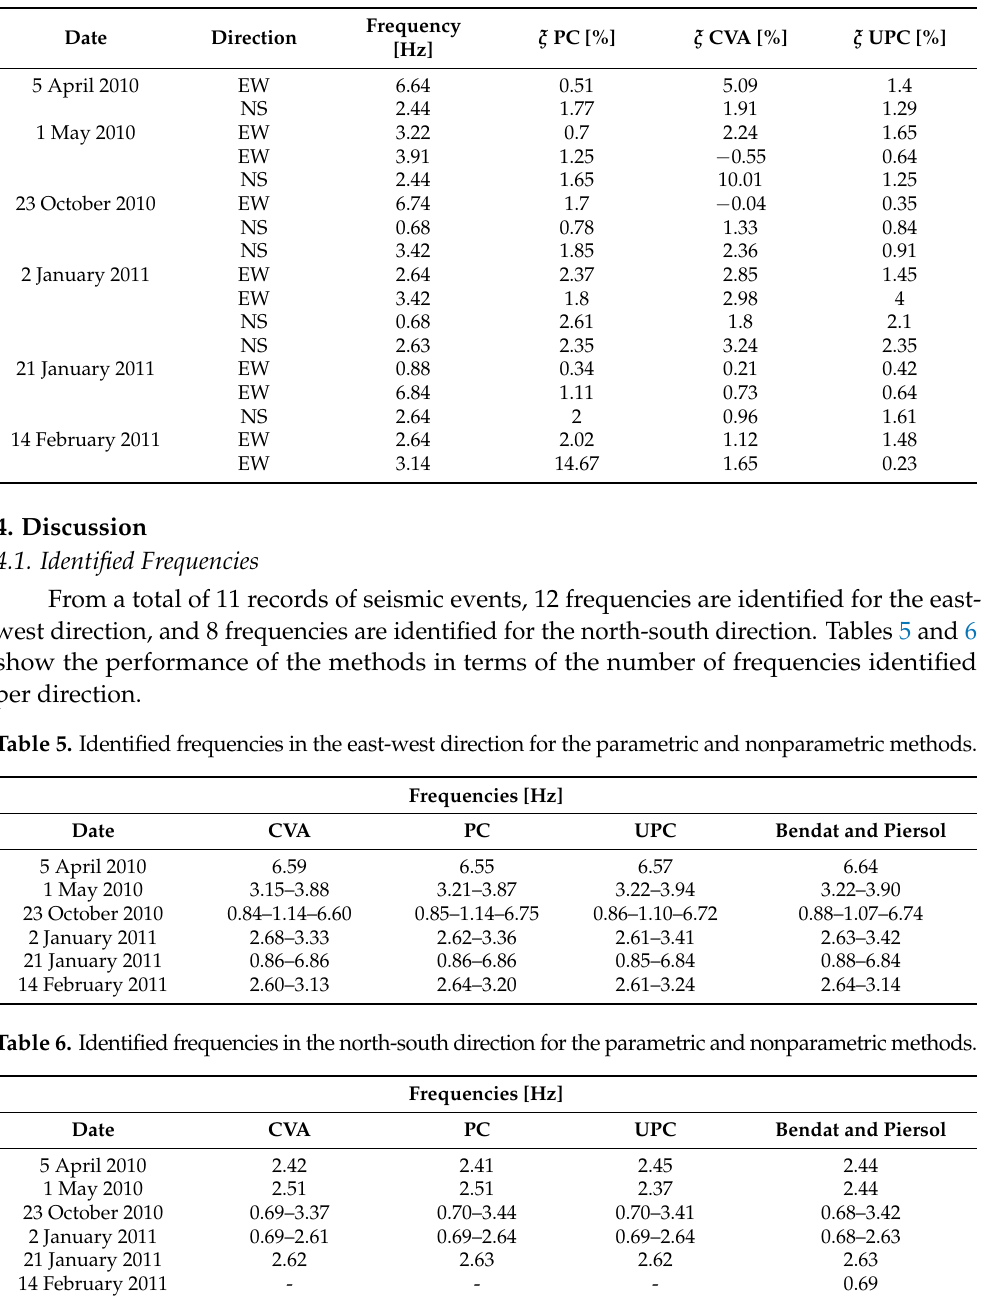
Table 4. Damping for the parametric method algorithms according to date, direction of analysis, and identified translational frequency.